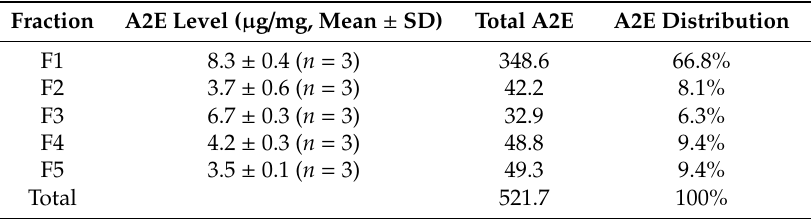
Table 2. A2E levels and distribution.